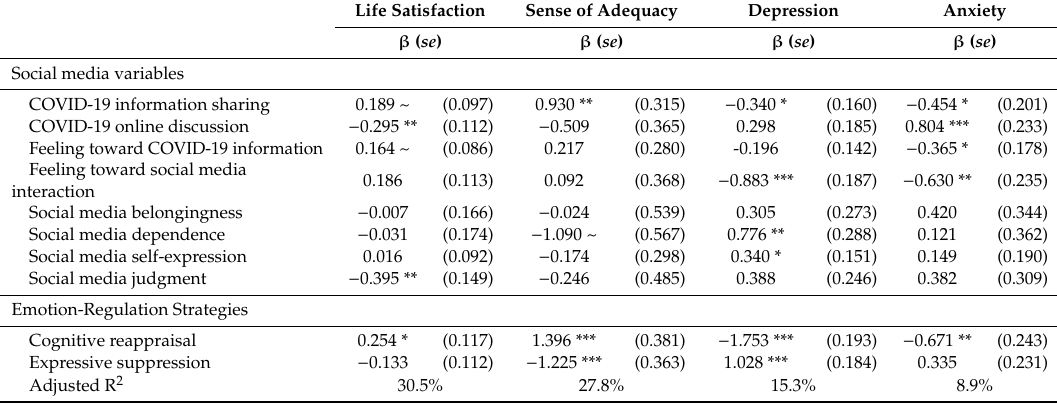
Table 3. Regression results on life satisfaction, sense of adequacy, depression, and anxiety. Life Satisfaction Sense of Adequacy Depression Anxiety